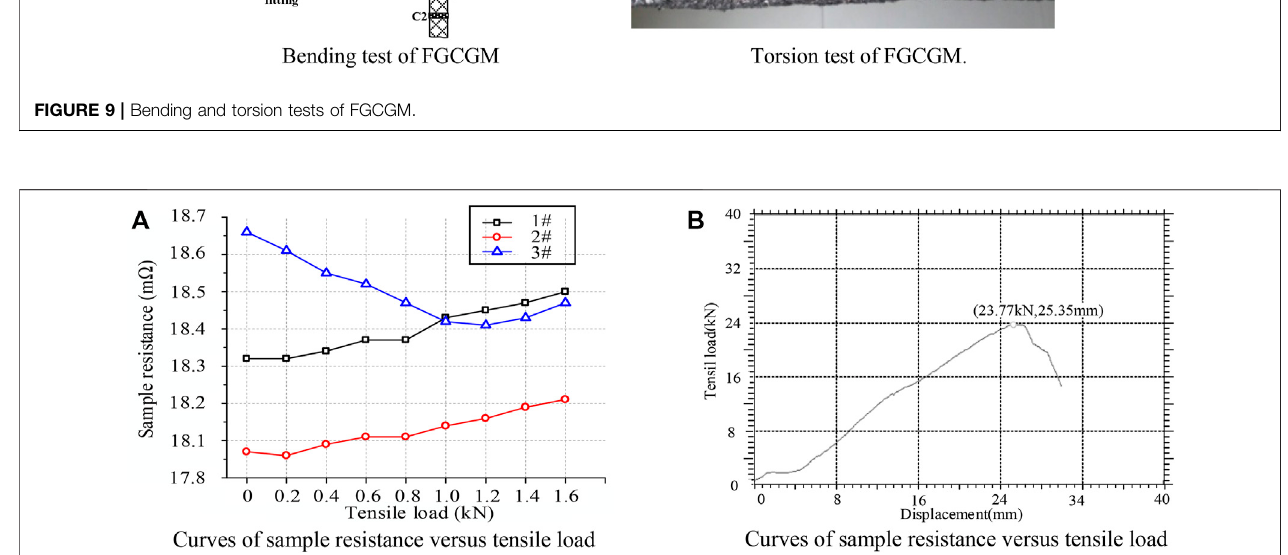
FIGURE 10 | Mechanical performance test results of